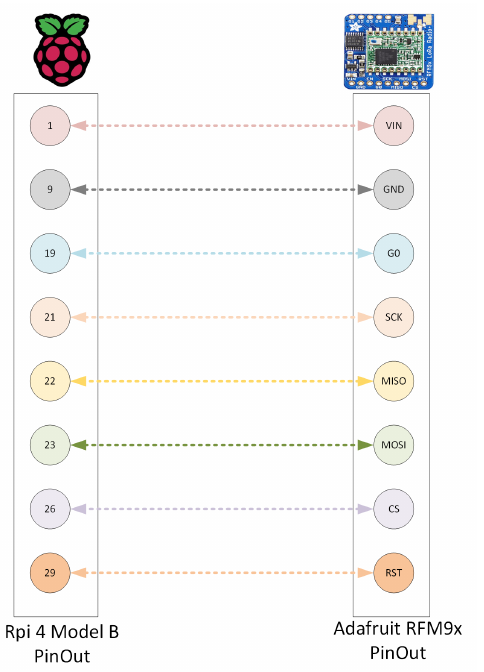
Figure 5. Wire cable connections between the Raspberry Pi and LoRa radio